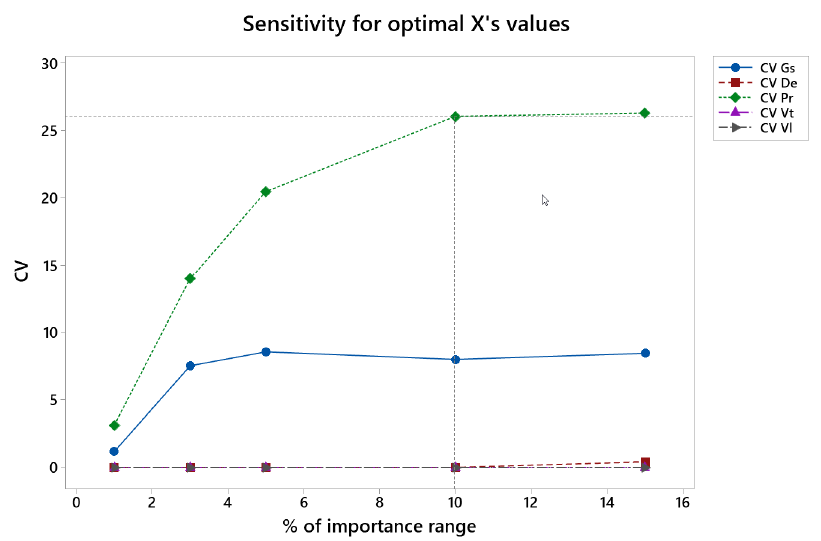
Figure 15. CV of the different factors vs. percentage of importance range in the finish honing operation.